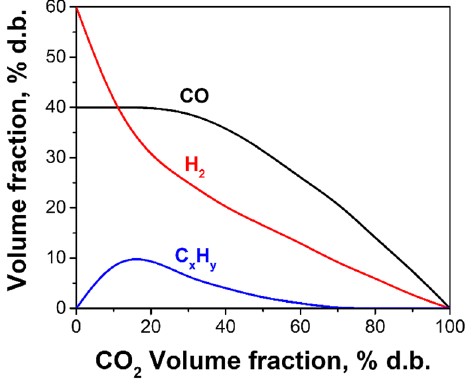
Figure 4. Measured syngas compositions in experiments with natural gas conversion and liquid/solid waste gasification by the detonation-born USS.